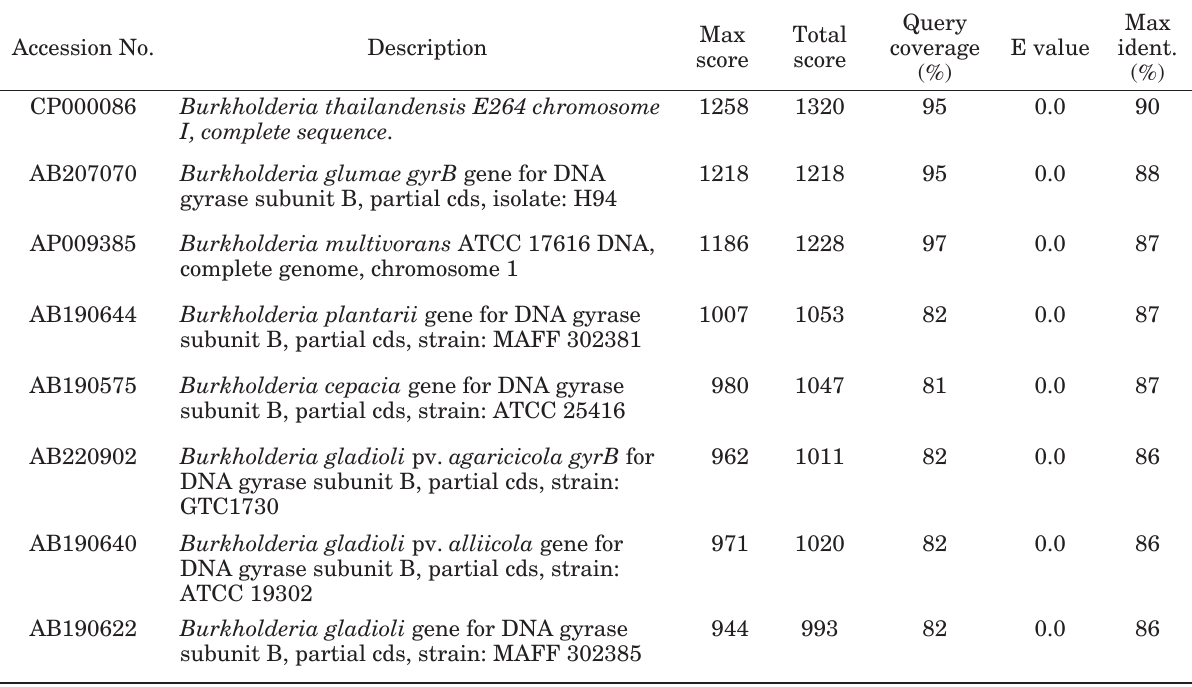
5. Comparison between Burkholderia sp. (strain DPPZ13, group A) gyrB gene sequence and other Burkholderia